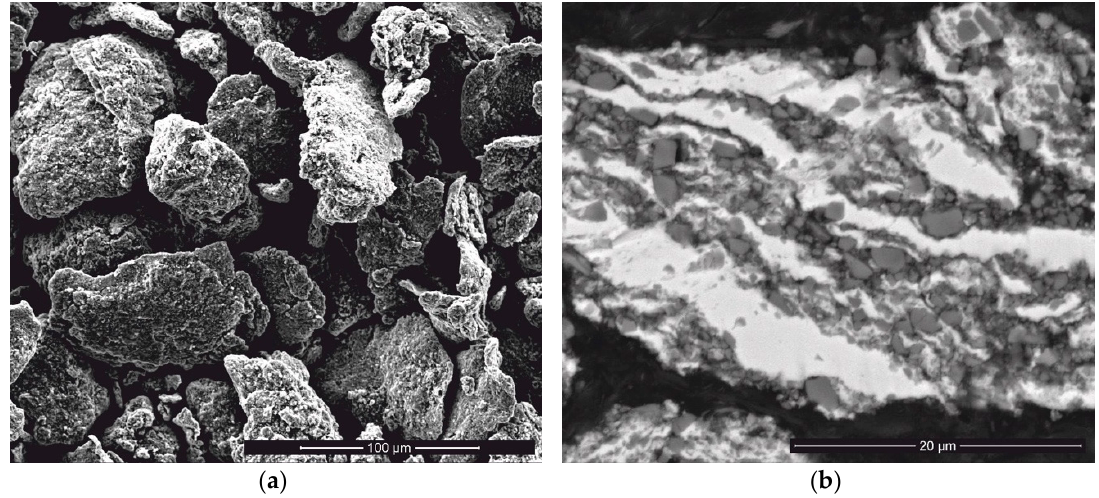
Figure 2. Morphology ( a ) and internal/cross cut structure ( b ) of Ti/SiC HEBMed powder agglomerates. Table 1. Agglomerate size distribution of Ti/SiC HEBM powder.